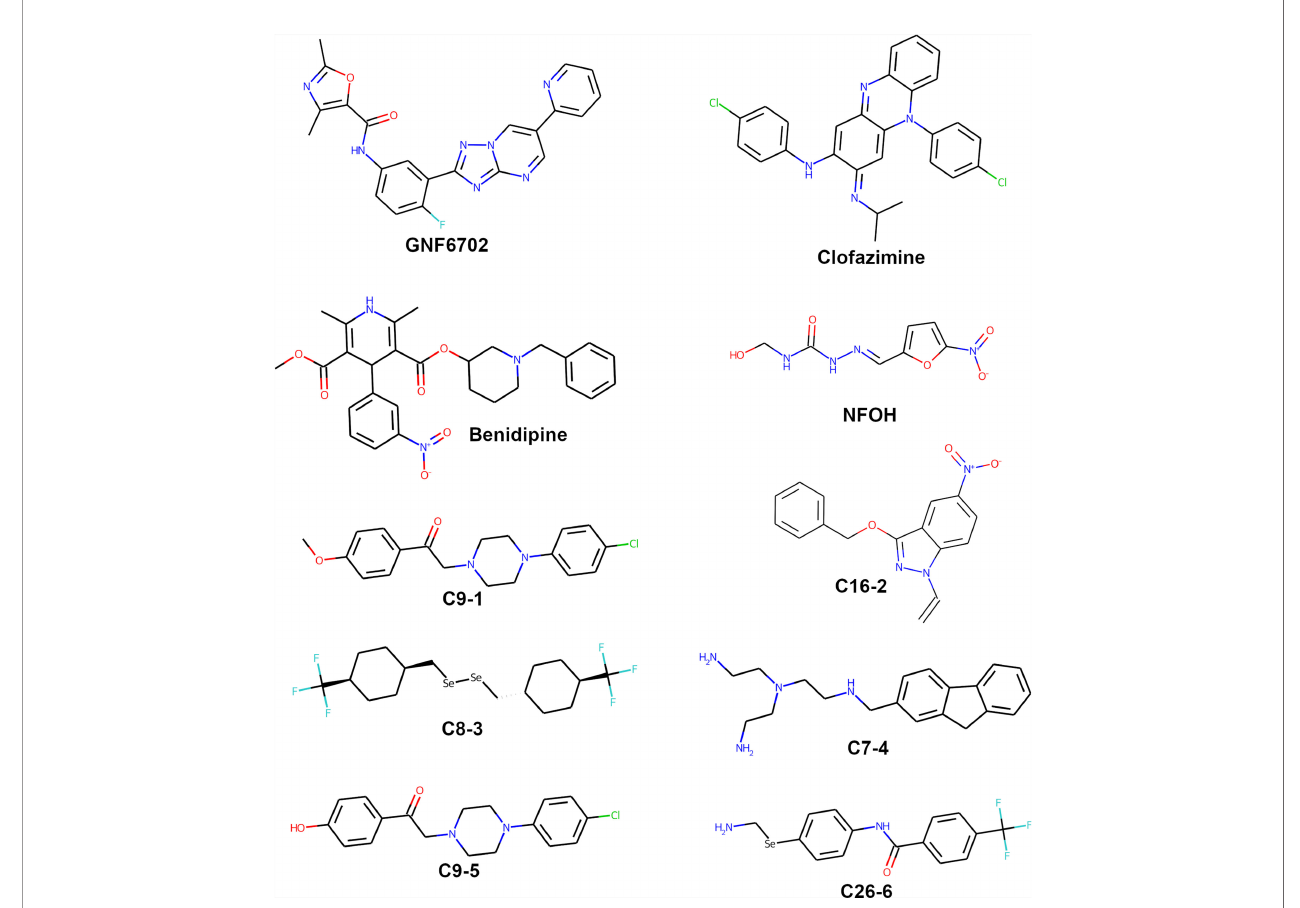
FIGURE 3 | Structures of compounds with anti- T.cruzi activity used in chronic experimental models of the